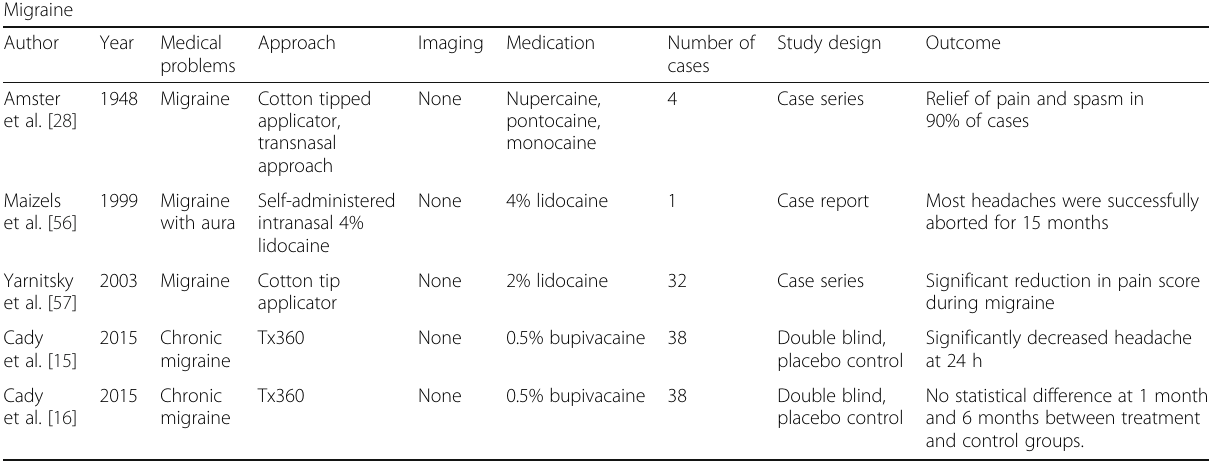
Table 5 Studies of SPG block for migraine